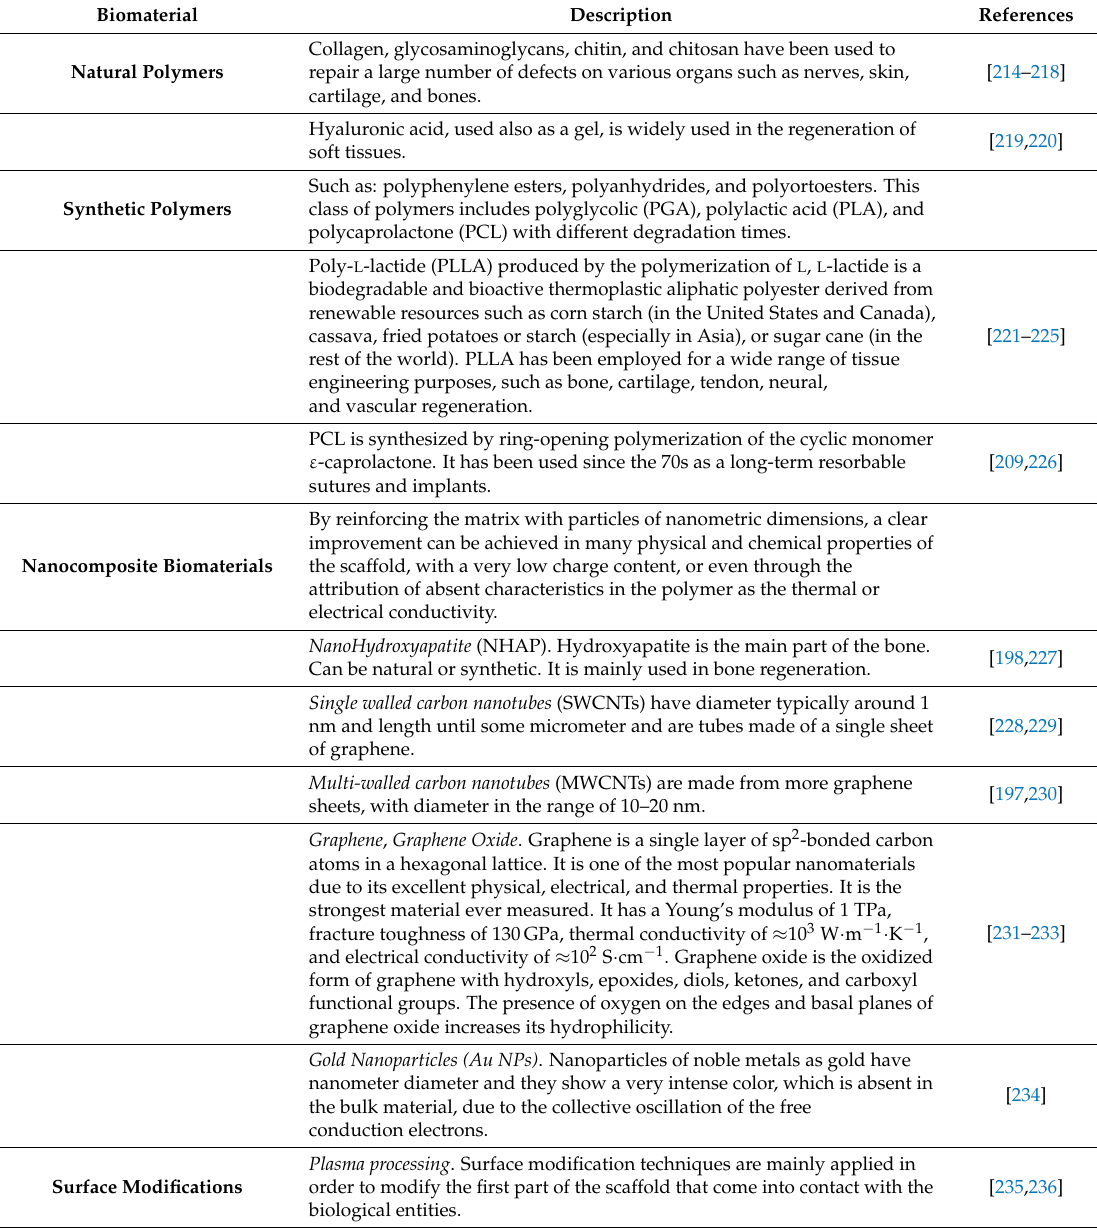
Table 3. Biomaterials for tissue engineering. The table describes the characteristics of the most commune biomaterials used in tissue